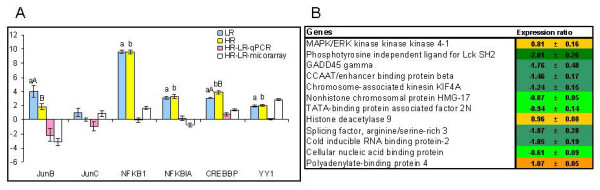
Signal transducers and regulators of gene expression. The figure shows expression changes indicative of recruitment and migration of immune cells. A. Real-time qPCR versus microarray analyses. Data for qPCR are ΔΔCt ± SE of 10 HR and 10 LR versus 8 fish in the unchallenged control and data for microarray are mean log2-ER ± SE of 6 HR fish hybridized to a pooled sample of 10 LR fish. Differences between HR and LR determined with microarrays and qPCR are shown. Different capital letters (A, B) denote a difference between challenged fish (HR and LR) while small letters (a, b) denote a difference between challenged and control fish (ANOVA, P < 0.05). NFKB1 - nuclear factor NF-kappa-B p105 subunit, NFKBIA - NF-kappa-B inhibitor alpha, CREBBP - CREB-binding protein, YY1 - YY1 transcription factor. B. Microarray results, examples of differentially expressed genes with significant differences between vaccinated and unvaccinated fish (t-test, n = 6 and 5, p < 0.05). Results for unvaccinated fish are not shown, data are log2-ER ± SE.